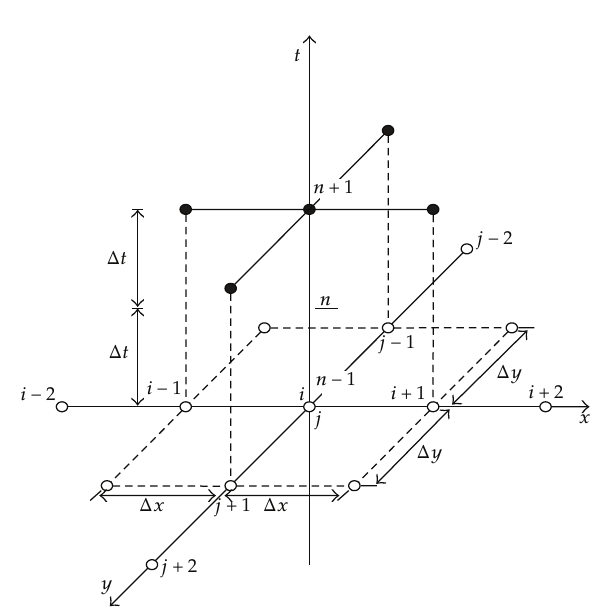
Figure 3: Computational mesh for the di ff usion-reaction